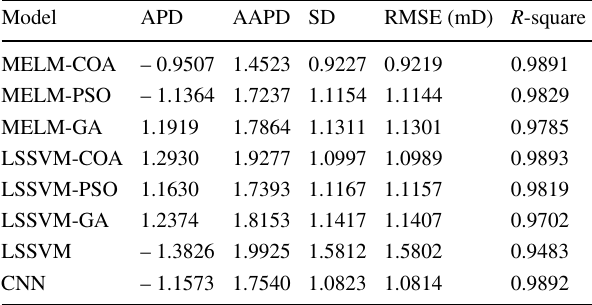
Table 8 Comparison of prediction results for the models proposed for predicting the permeability from the validation data of well B with respect to four error indices and R 2 Model